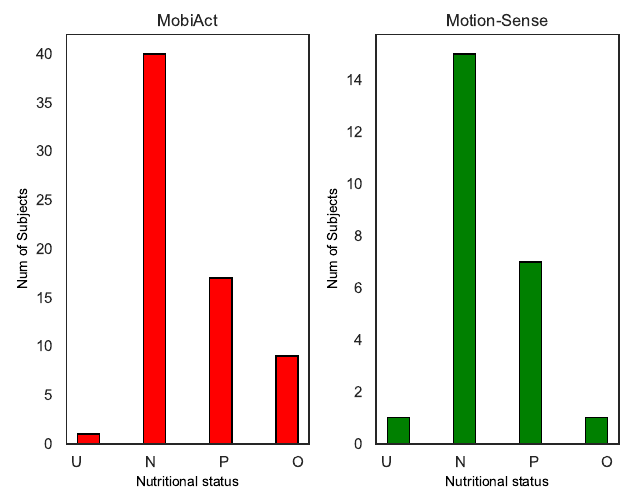
Figure 3. The nutritional status related to BMI of the two datasets. U: underweight; N: normal weight; P: pre-obesity; O: